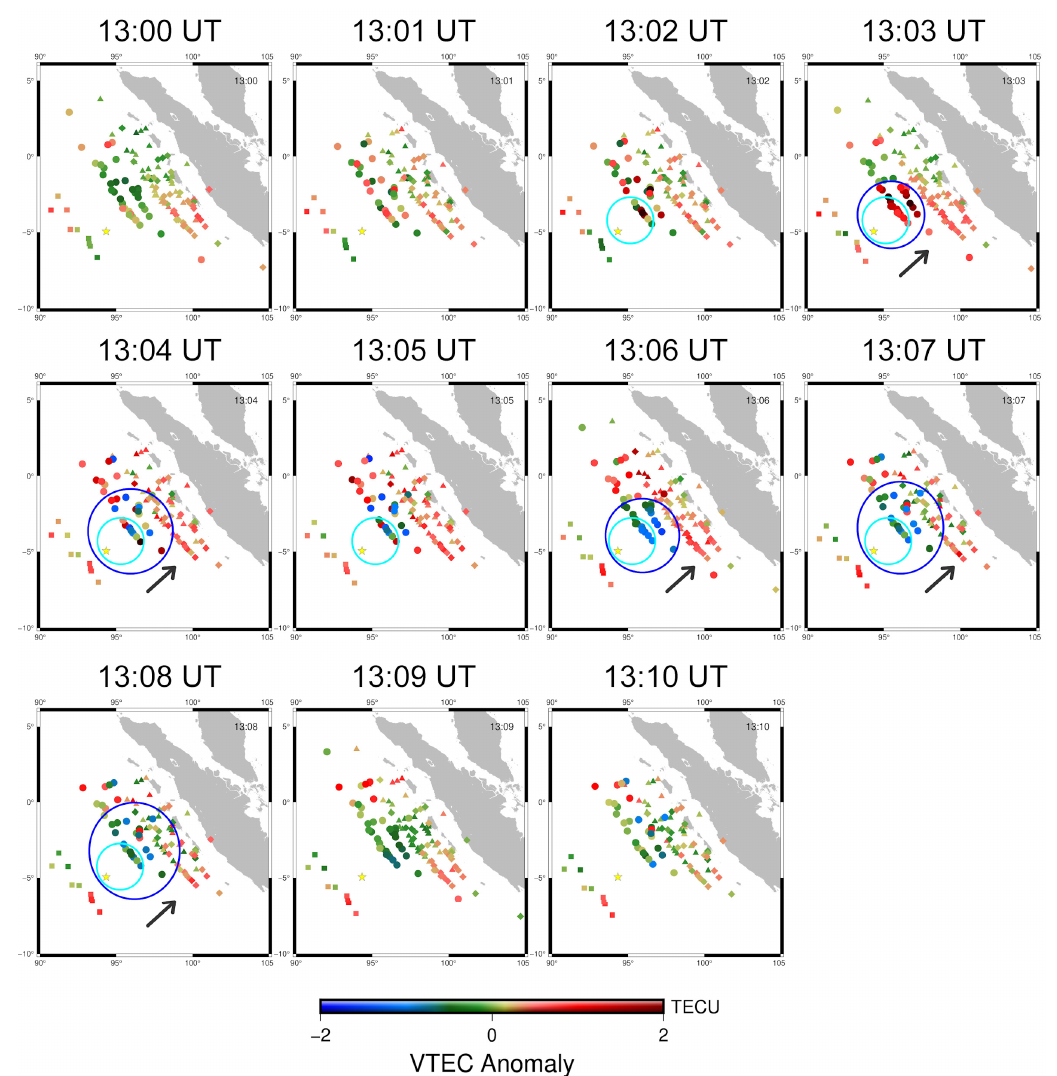
Figure 10. Directivity of CID at an altitude of 300 Km. The light blue indicates the beginning of the emergence of CID and followed by the dark blue circle and the black arrow indicate the direction and area of movement the positive CID. The positive anomaly starts to increase at 13.02 UT